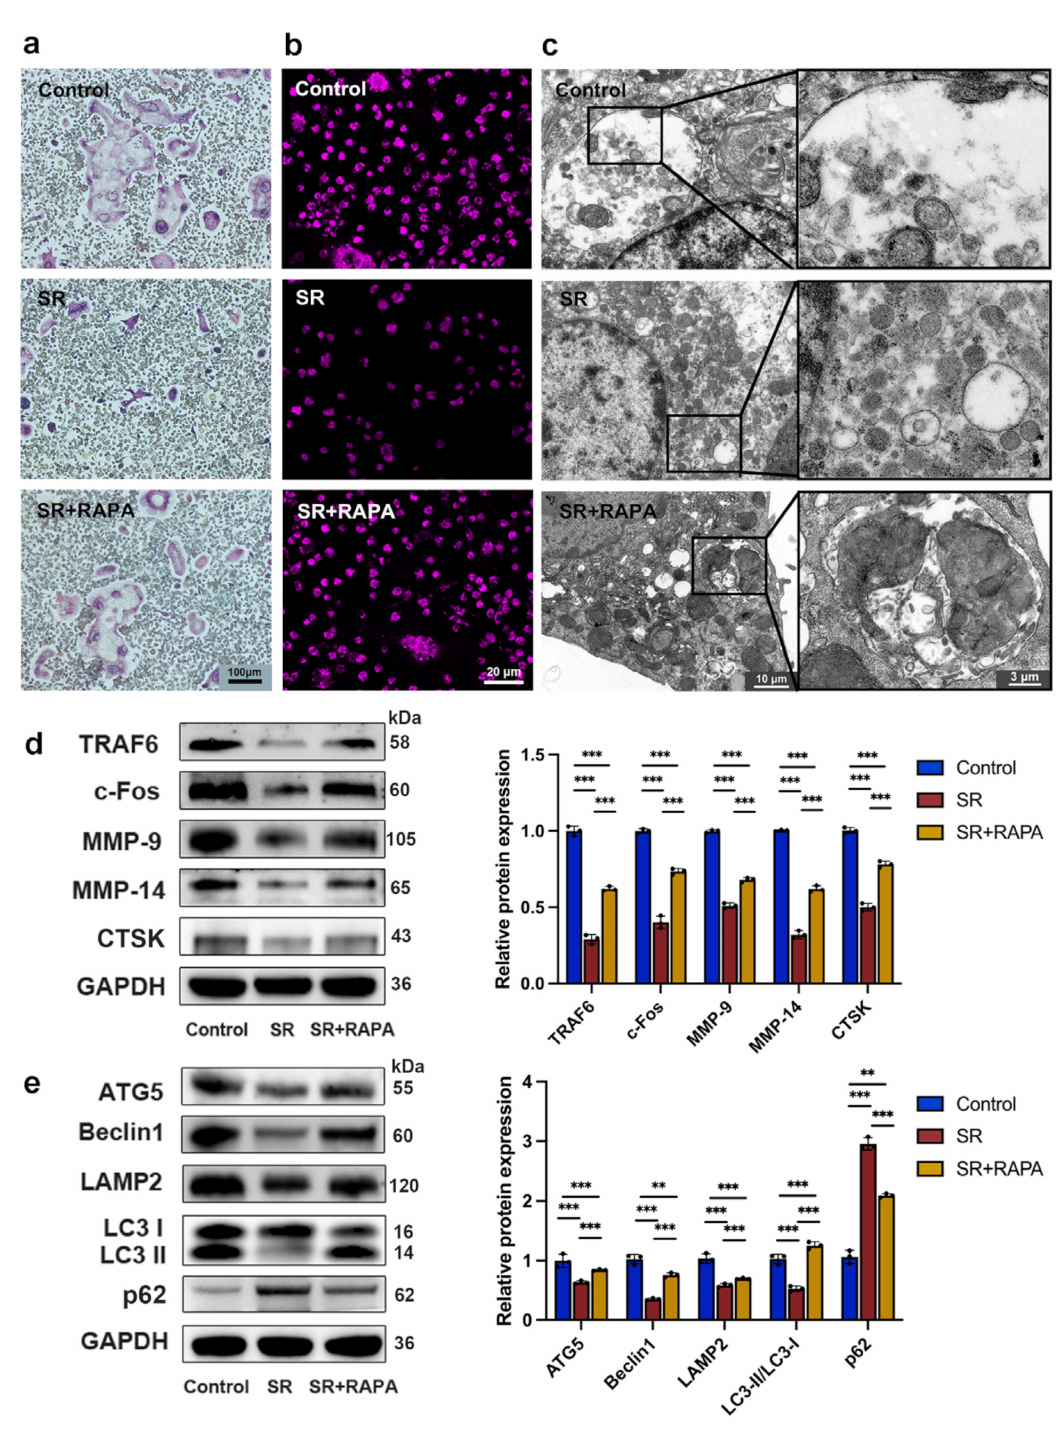
Figure 1. Strontium ranelate suppressed osteoclast differentiation through autophagy in vitro. ( a ) TRAP staining images after pre-osteoclasts received different treatments for 5 days. ( b ) Mon- odansylcadaverine staining images after pre-osteoclasts received different treatments for 5 days. ( c ) Representative images of autophagosomes captured with a transmission electron microscope after pre-osteoclasts received different treatments for 5 days. Western blot assay and relative protein ex- pression of the osteoclast markers TRAF6, c-Fos, MMP-9, MMP-14, and CTSK ( d ) and the autophagic proteins Beclin1, ATG5, LAMP2, LC3-I, LC3-II, and p62 ( e ) after pre-osteoclasts received different treatments for 5 days. (n = 3, mean ± SD, ** p < 0.01, *** p <